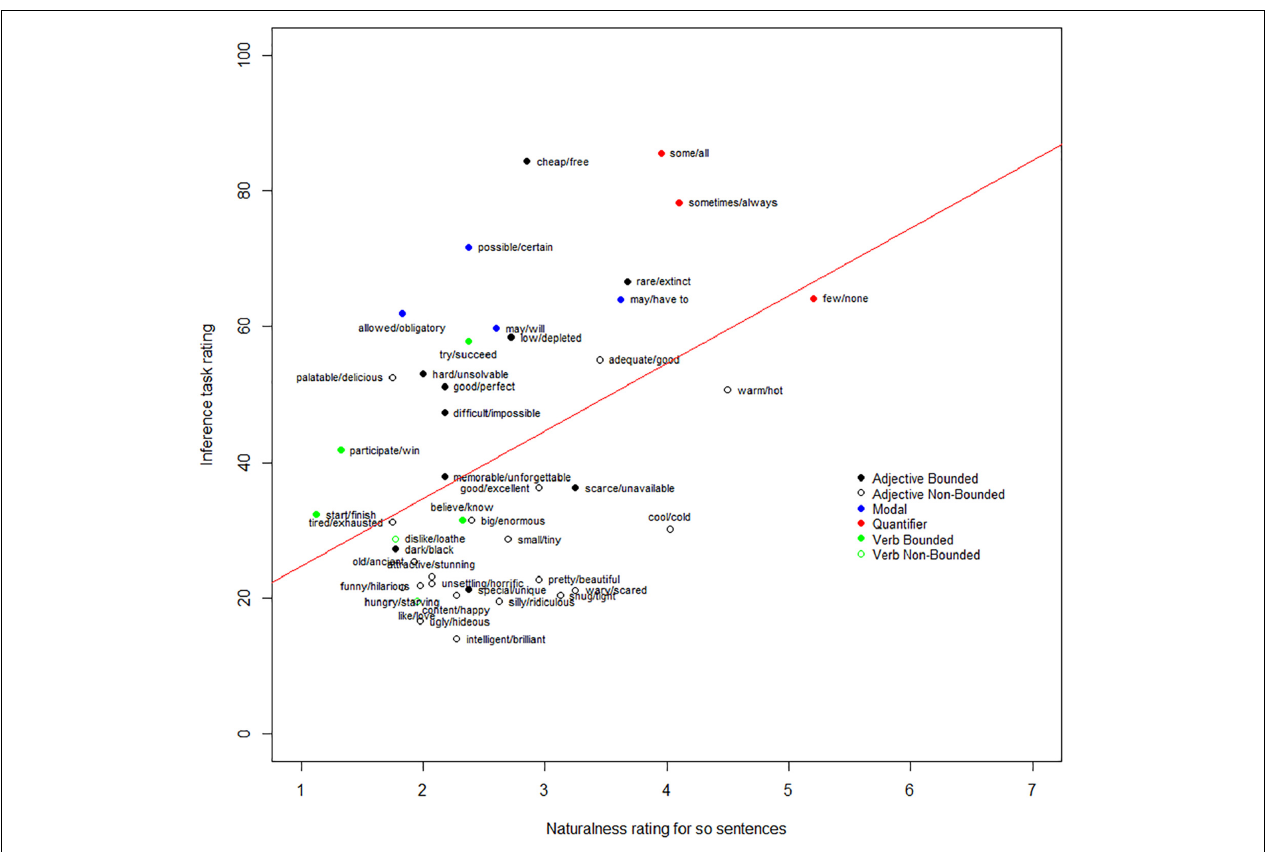
FIGURE 6 | Positive correlation between the propensity of local enrichment and inference rate.